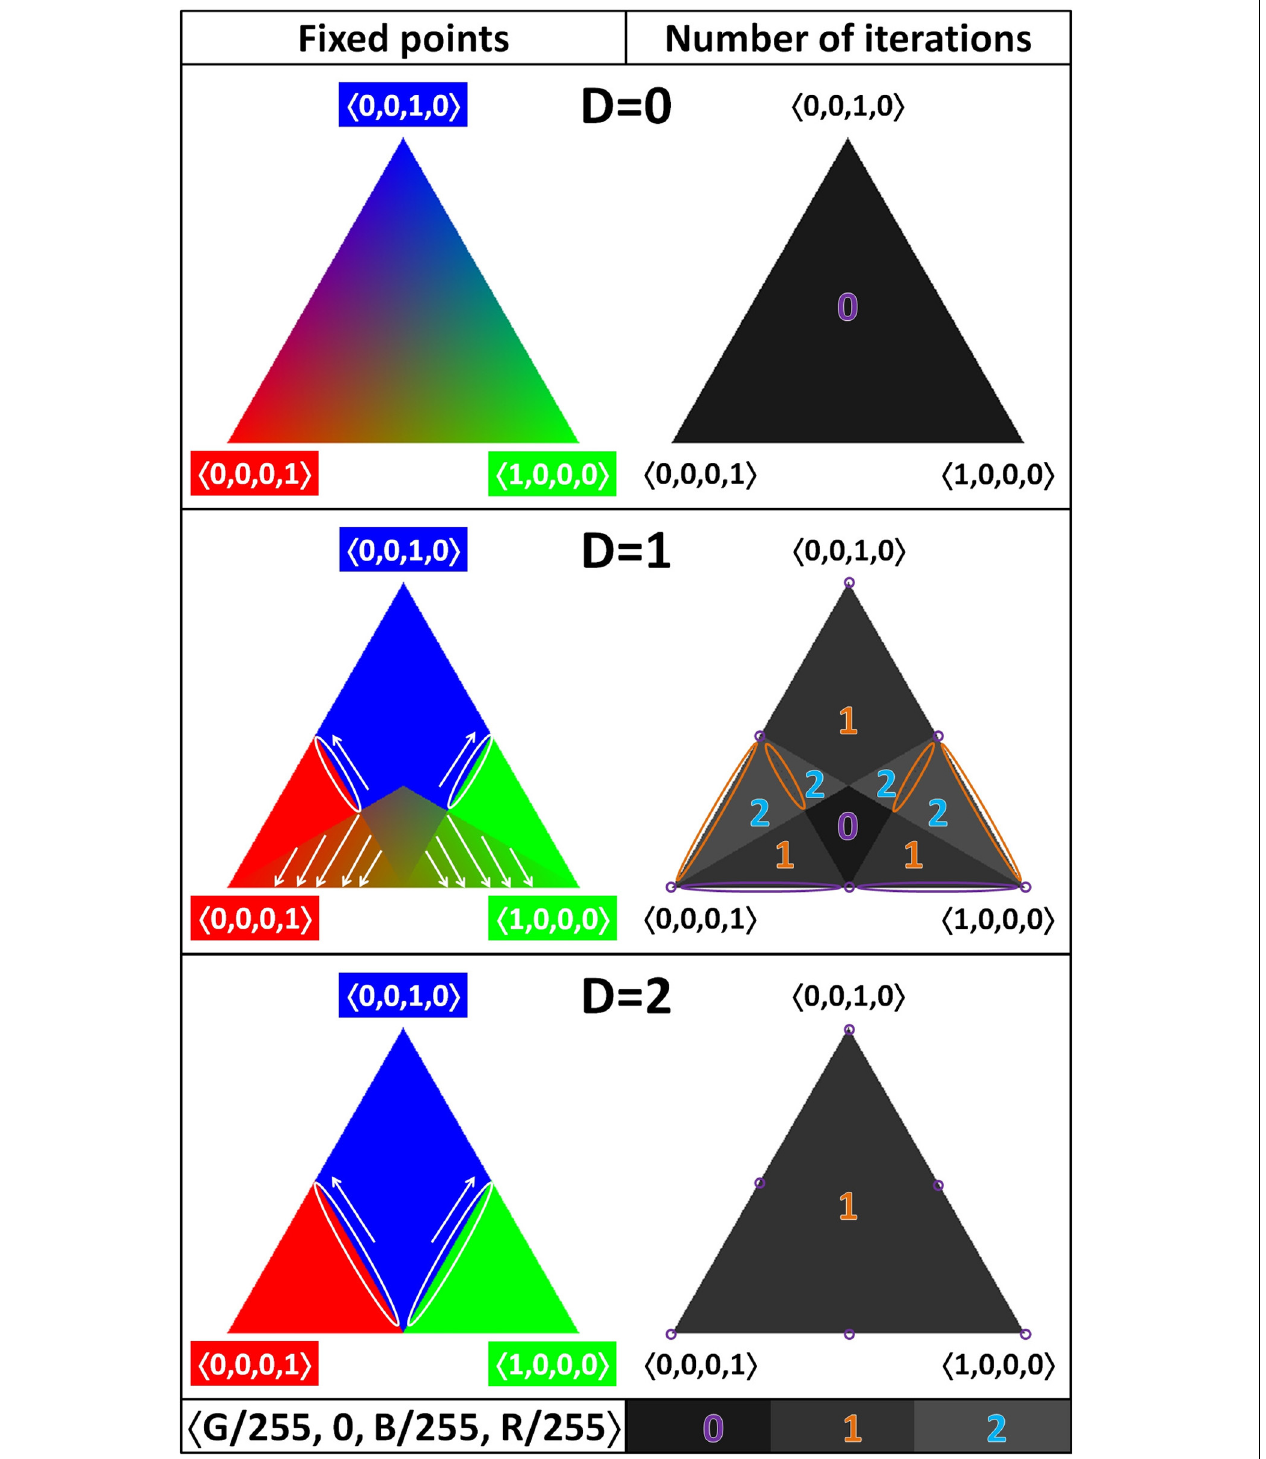
FIGURE 6 | Opinion dynamics for M = 1: one face of the opinion density space (ODS). On the left-hand side, each position in the ODS is colored depending on its final state (see main text for details); smaller features are indicated with white ellipses and arrows. On the right-hand side, each position in the ODS is given a gray-scale value depending on